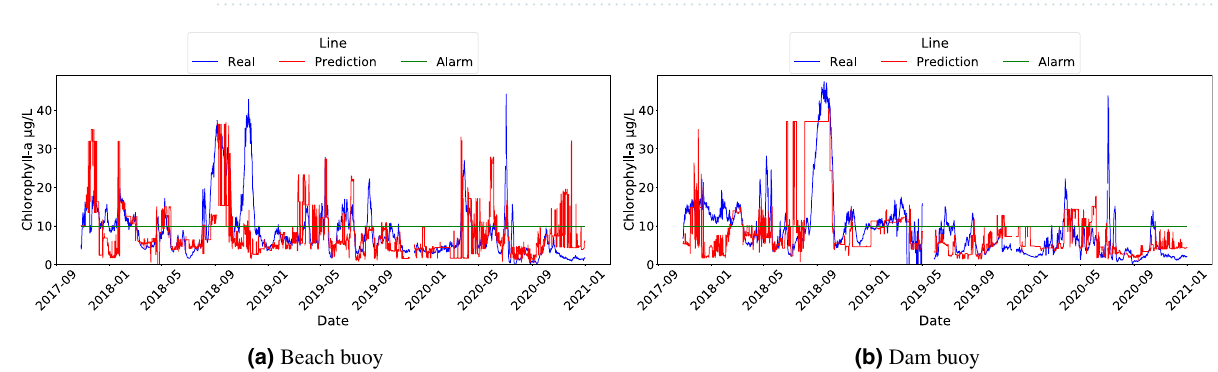
Figure 8. Comparison of various input aggregation and output aggregation methods using Random Forest: Beach buoy in terms of MAE ( a ); Dam buoy in terms of MAE ( b ); Beach buoy in terms of F1 ( c ); Dam buoy in terms of F1 ( d ).